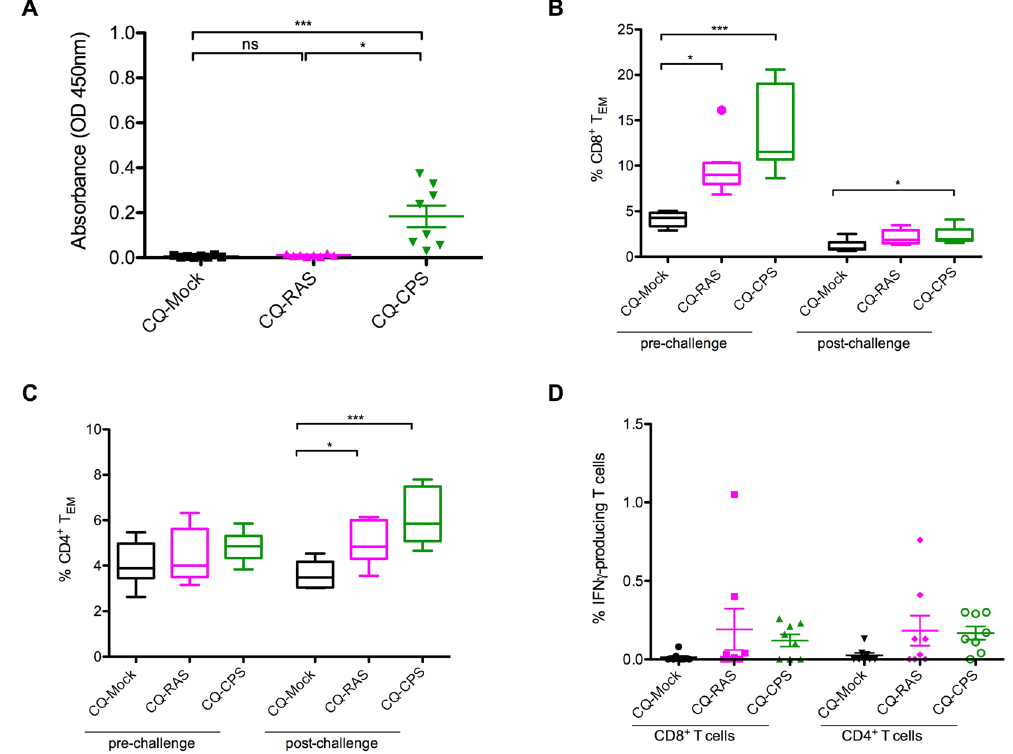
Figure 5. Humoral and cellular immune responses in CQ-RAS and CQ-CPS immunized mice versus CQ- Mock controls. ( A ) Antibody responses to late blood-stage lysates in CQ-RAS (n = 8), CQ-CPS (n = 8) and control mice (n = 8) 14 days before challenge. Sera of immunized and control mice were analyzed by ELISA. ( B ) and ( C ) Flow cytometric assessment of the CD8 + T cell (B) or CD4 + T cell ( C ) activation status in CQ-RAS (n = 8) and CQ-SPZ (n = 8) immunized mice versus CQ-Mock controls (n = 8). Samples were collected 2 weeks before (pre-challenge) or 4 days after (post-challenge) challenge with 10 5 iRBC. ( D ) Flow cytometric assessment of IFNy-producing T cells after stimulation with blood-stage lysates in CQ-RAS (n = 8) and CQ-SPZ (n = 8) immunized mice versus CQ-Mock controls (n = 8) 2 weeks before challenge (pre-challenge). IFNy responses from non-stimulated cells (background) were subtracted from stimulated values. * P < 0.05; ** P < 0.01; *** P < 0.001 (Kruskal- Wallis test with Dunn’s Multiple Comparison